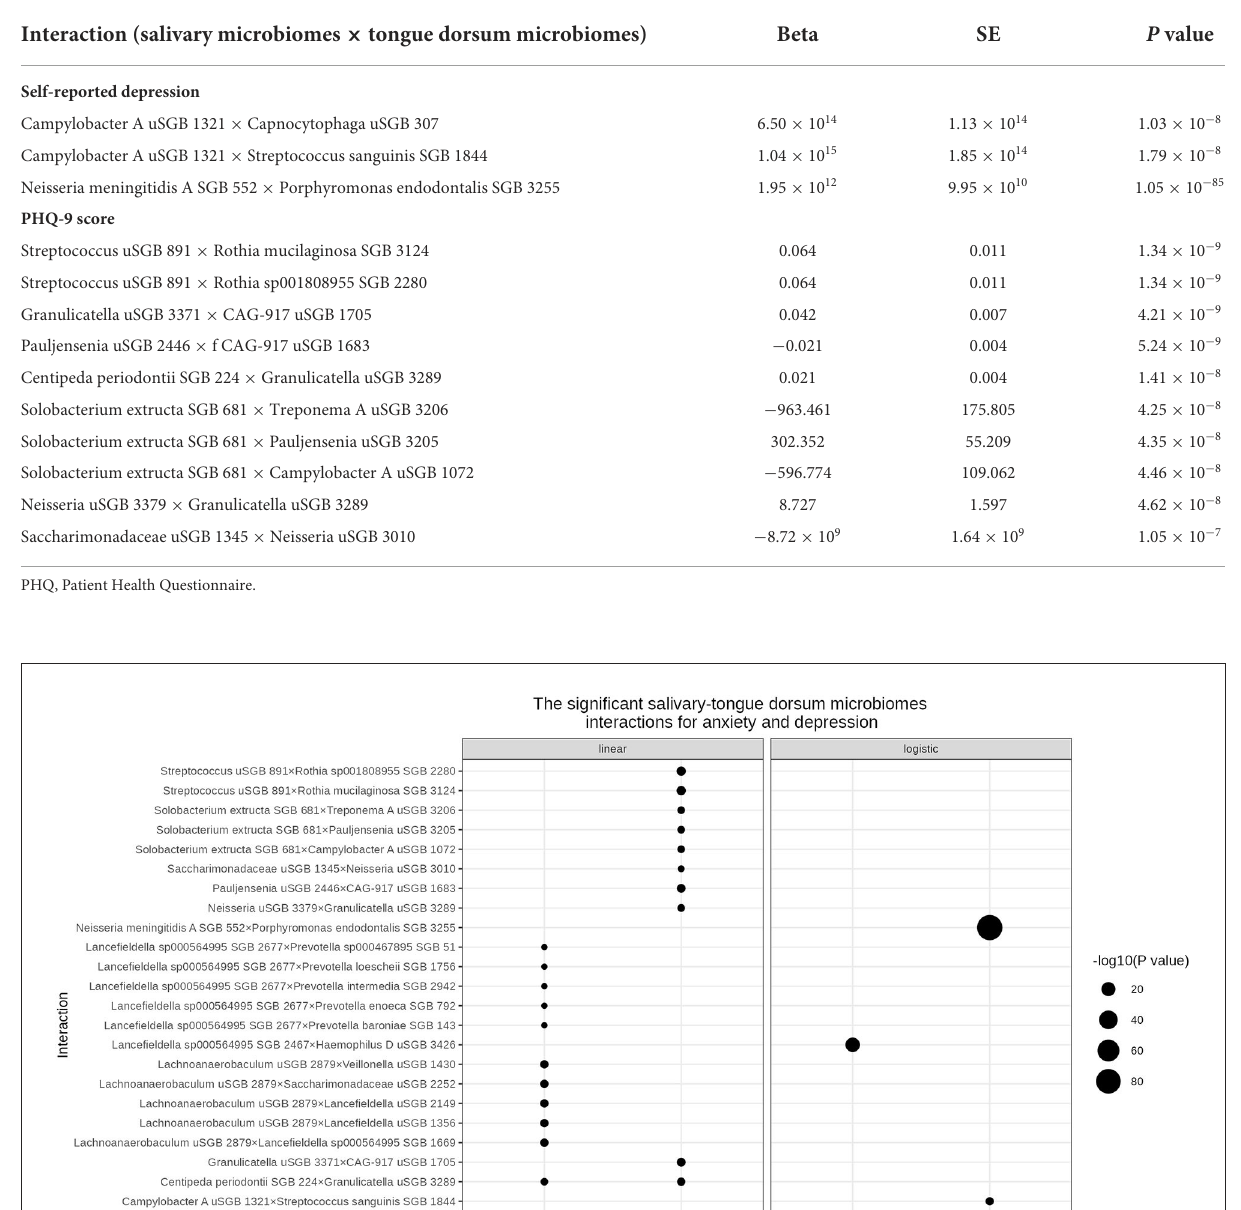
= 9.83 × 10 − 8 , P Finngen − IVW = 3.16 × 10 − 16 , and P − 16 ) and Lancefieldella uSGB Finngen − WME = 1.43 × 10 2940 in tongue dorsum microbiomes (P UKB − IVW =